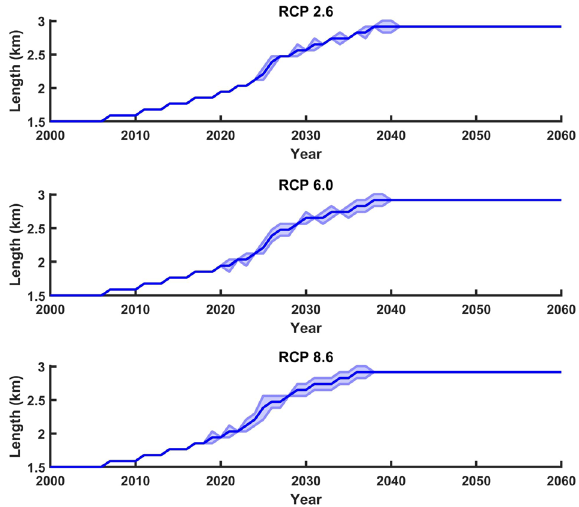
Figure 8. Uncertainty associated with the future lake lengths. The shaded regions represent the uncertainty in the lake lengths. (URL: www. mathw orks.